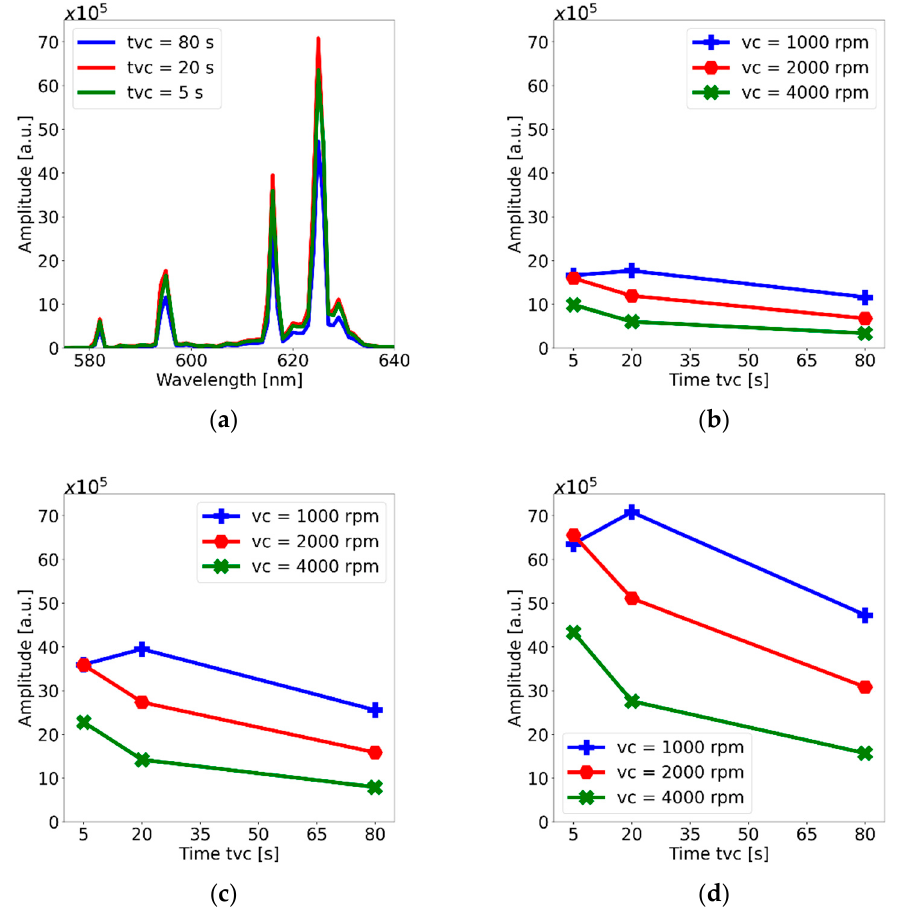
Figure 9. ( a ) Fluorescence spectra for the membranes with concentration of 62.5% wt./wt. fabricated at 1000 rpm. Changes in the three mean fluorescence peaks for membranes at concentration of 62.5% wt./wt.: ( b ) 595 nm, ( c ) 616 nm and ( d ) 625 nm.